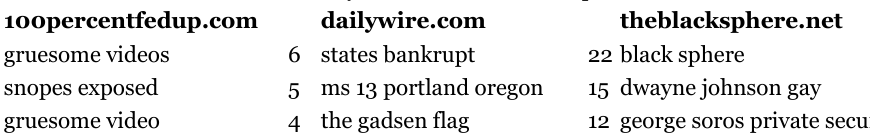
Table 2: A sample list of up to ten keywords from each junk news domain in the sample when the keyword reached the first